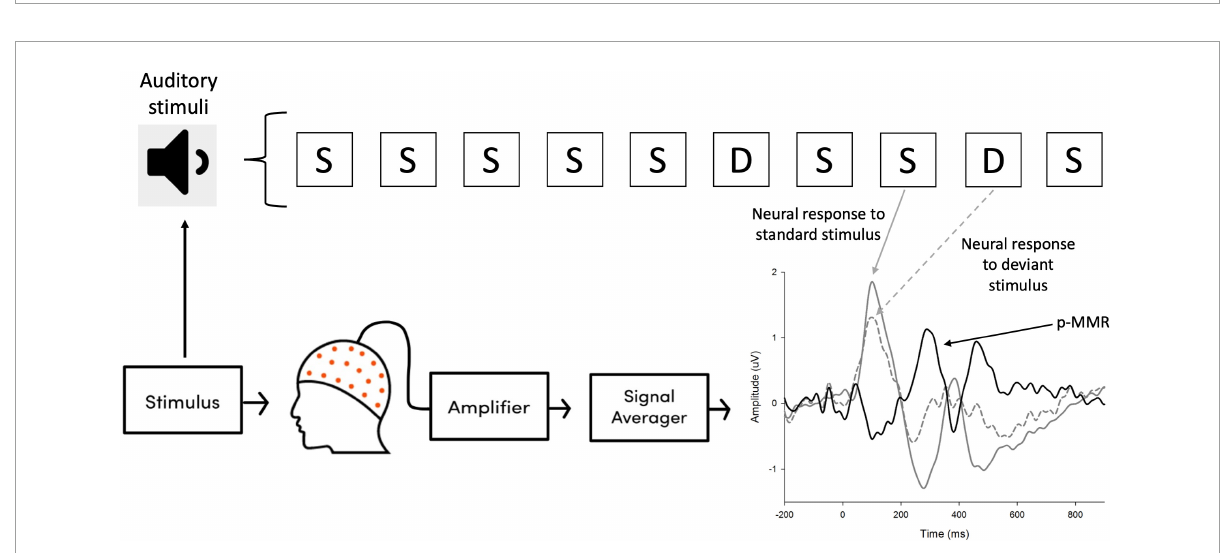
FIGURE2 The signal recording paradigm in this study. Neural responses evoked by the auditory stimuli were amplified by the amplifier, which was then processed and averaged across trials. The positive mismatch response (p-MMR) was obtained by subtracting the event-related potentials (ERPs) elicited by standard stimuli (S) from those elicited by deviant stimuli (D).